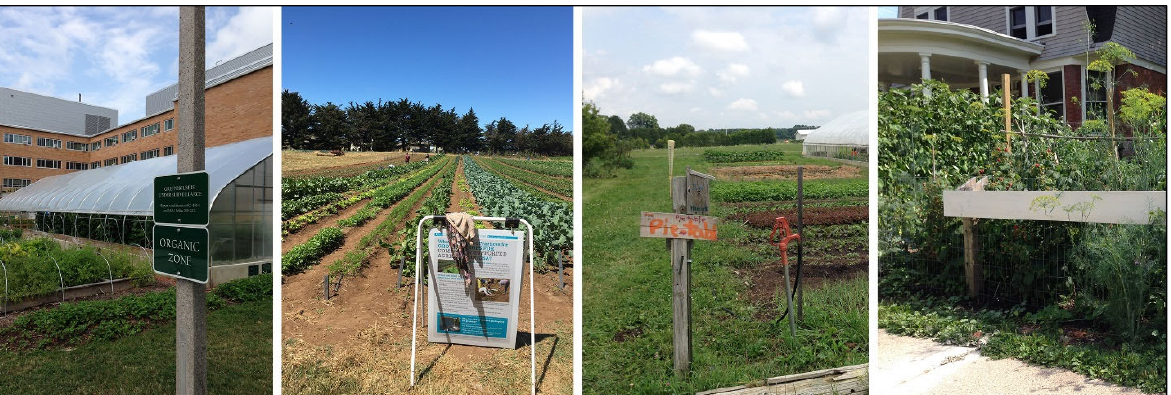
Figure 6. Professional Signage (Left and Center Left); Dilapidated Handmade Signage (Right and Center